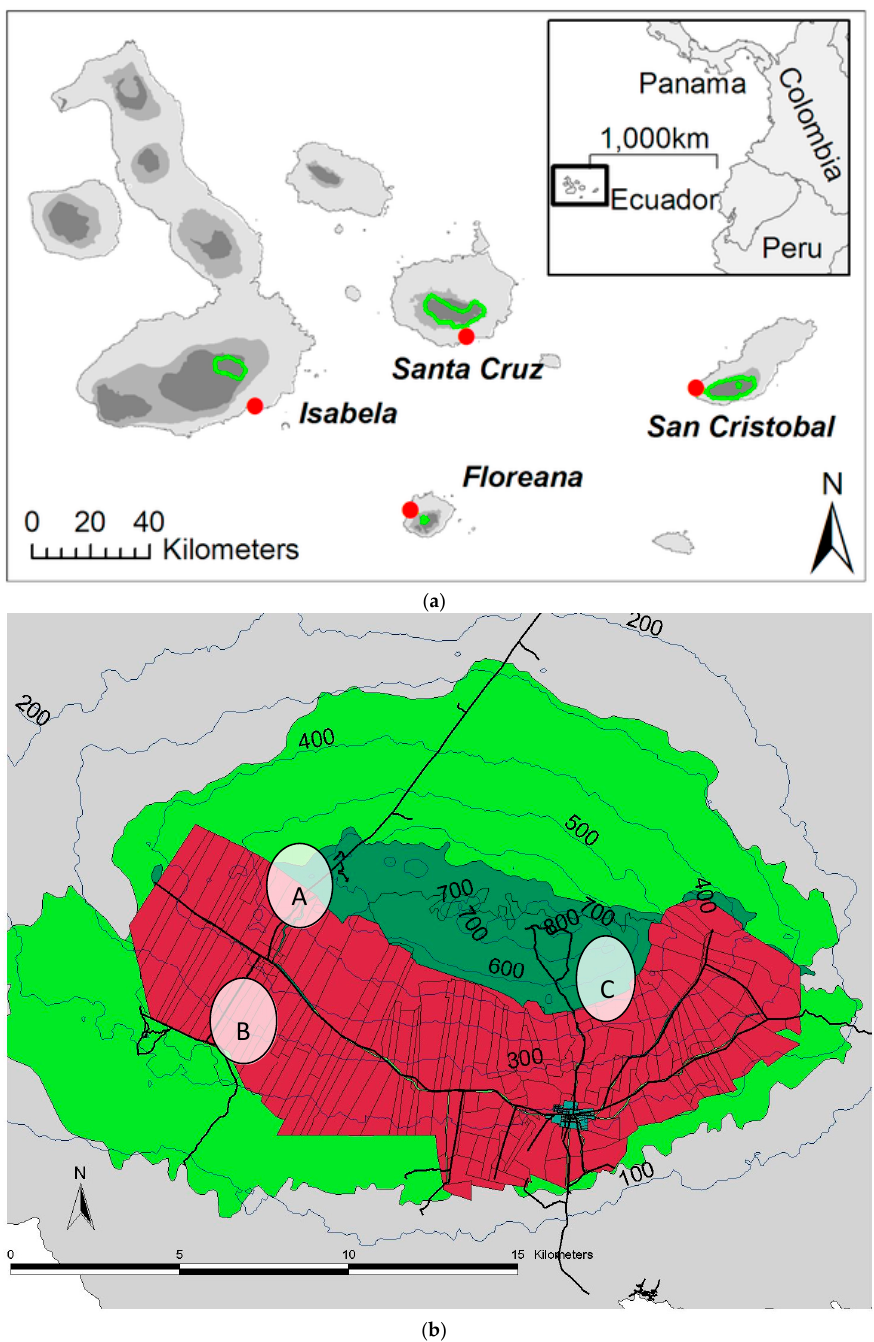
Figure 6. ( a ) Geographical location of Galápagos in relation to mainland Ecuador. Figure 6. Location map of Galapagos, showing the broad climatic zones (light: arid, medium: transition, dark: humid) from [48] Guézou A, Trueman M, Buddenhagen CE, Chamorro S, Guerrero AM, et al. (2010) An Extensive Alien Plant Inventory from the Inhabited Areas of Galapagos. PLOS ONE 5(4): e10276. https: // journals. plos.org / plosone / article / figure?id = 10.1371 / journal.pone.0010276.g001. Copyright @2010Gu é zou et al. ( b ) Highlands of Santa Cruz Island shows the current agricultural zone (in red) and the dots indicate the location of the sites in study: (A) Granillo Alto and Granillo Bajo, (B) Fundar Galapagos, and (C) Cerro Mesa4.2. Flora Mycorrhizal Status